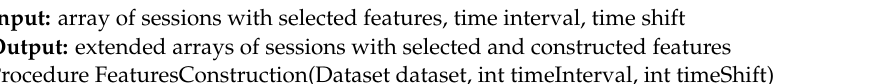
Algorithm 2. Feature construction